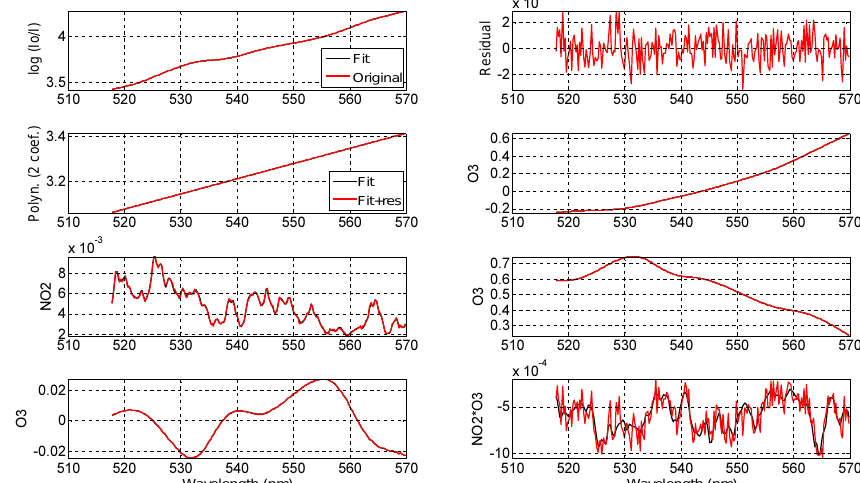
Figure 7. DOAS evaluation of a simulated limb spectrum at TH = 19.83km. The simulated spectrum is shown on top left, the fit residual on top right. The remaining plots show fit results for the individual OD terms listed in Table 1, third